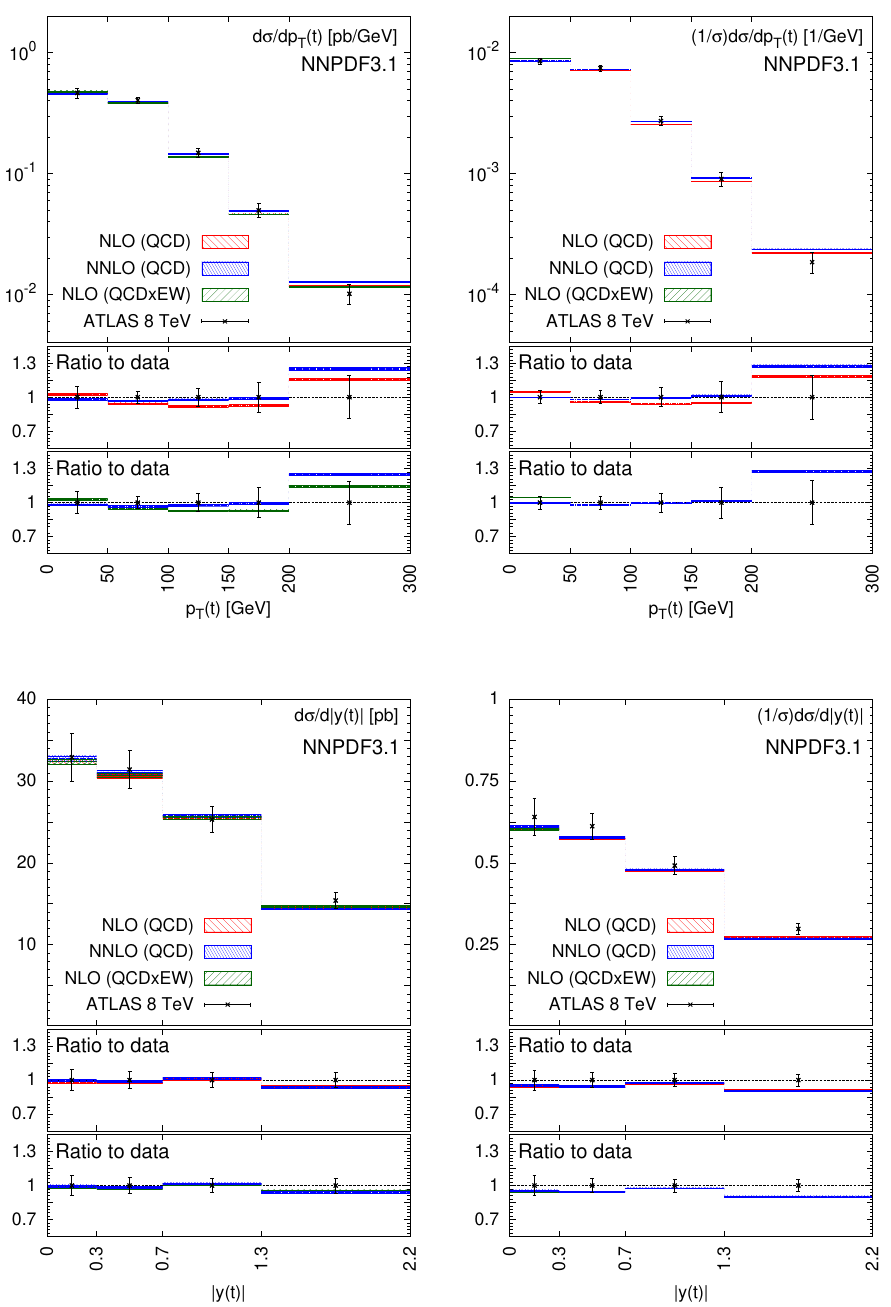
Figure 18 . Same as (cid:12)gure 3, but for the ATLAS data of ref. [13].